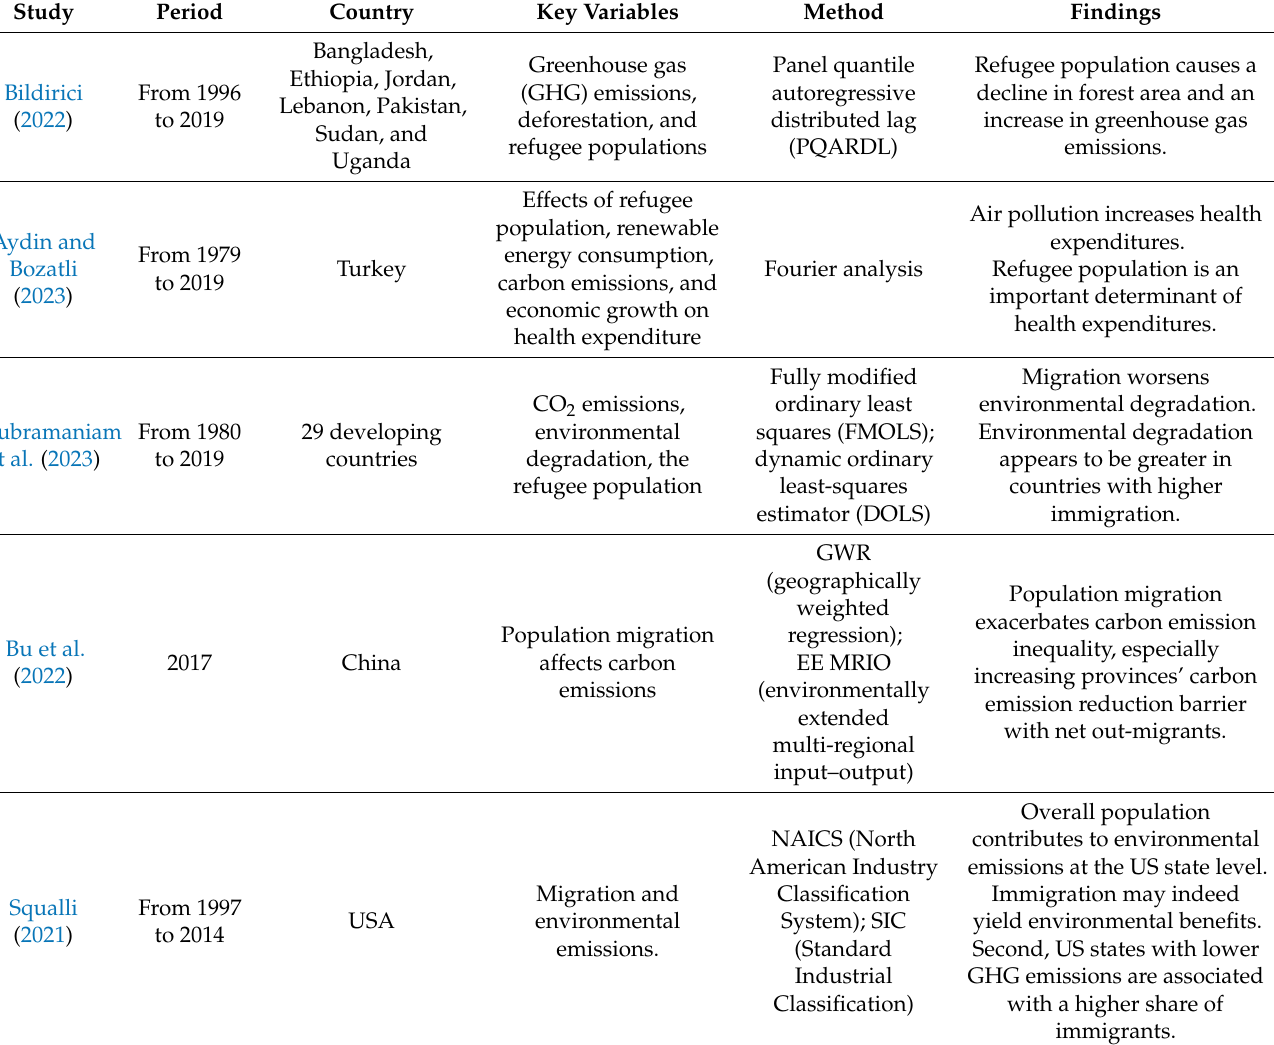
Table 1. Summary of related studies on refugee aspects and environmental quality